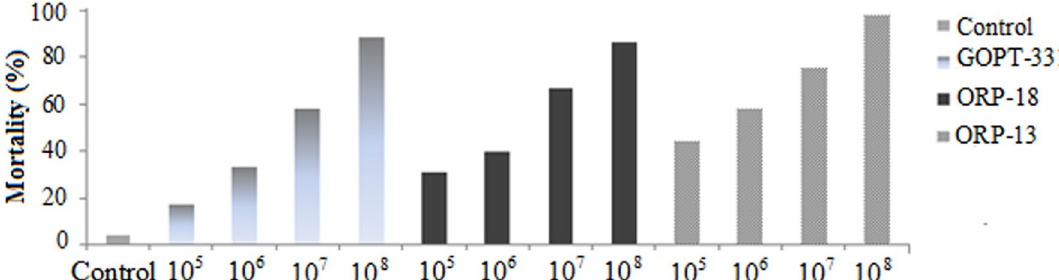
Fig. 2 Mortality rates of the fourth larval instar of Thaumetopoea wilkinsoni exposed to different fungal isolates